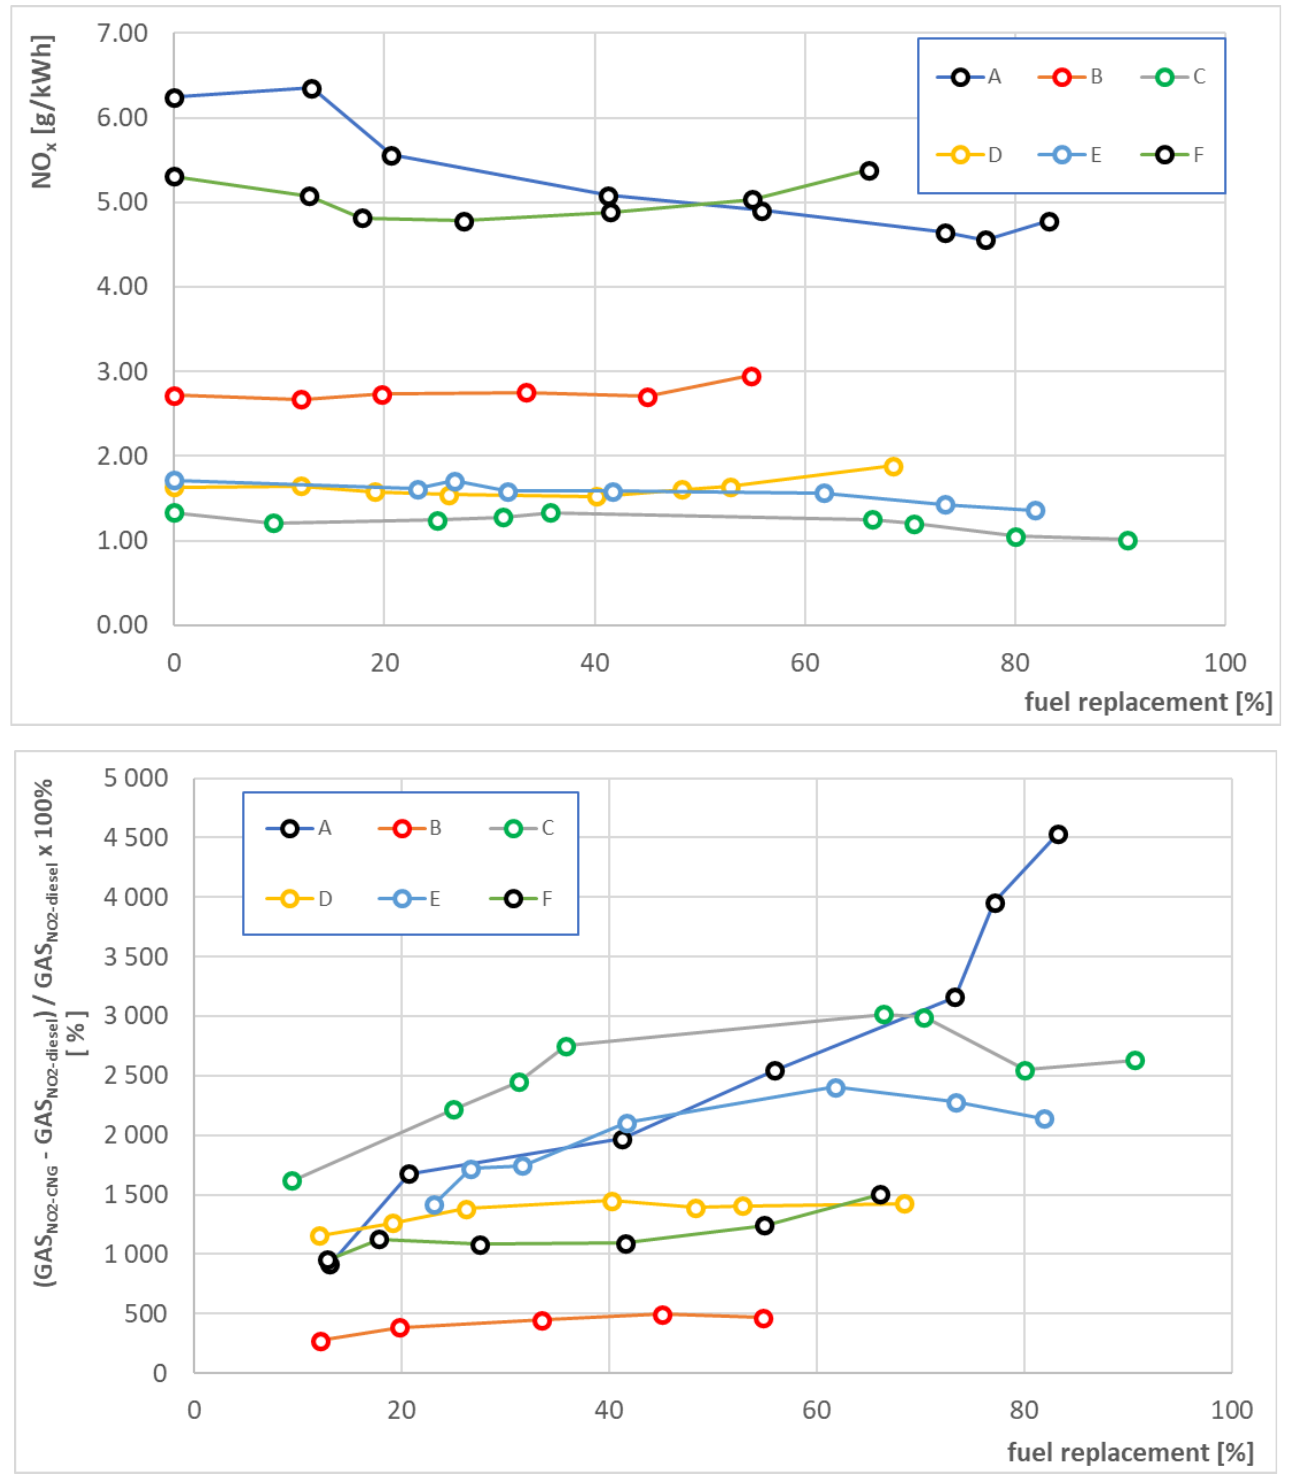
Figure 9. Curves from A to F showing engine’s emission of NO X (nitrogen oxides), for individual engine operating points, where the rotation speed, power, and torque were constant, as a replacement function of diesel fuel replaced by CNG.